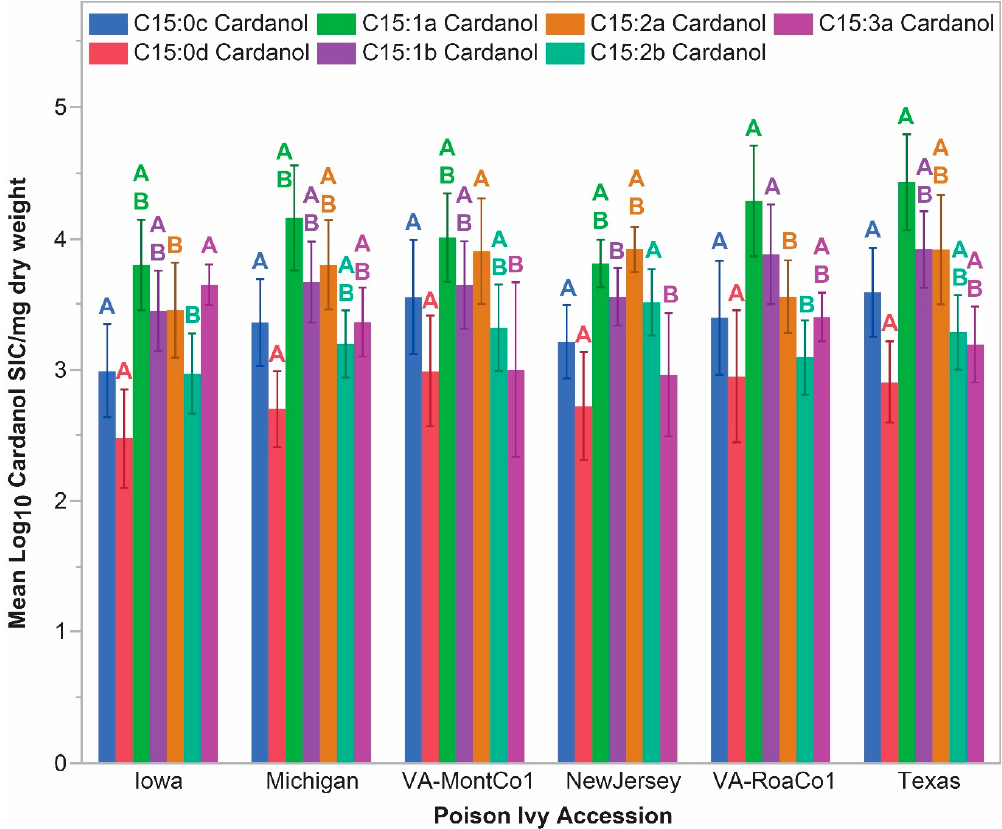
Figure 7. C15-cardanol congener and isomer steady state accumulation levels. Error bars indicate standard deviation. Non-shared letters of the same color indicate statistically significantly different least square means between the poison ivy accessions.